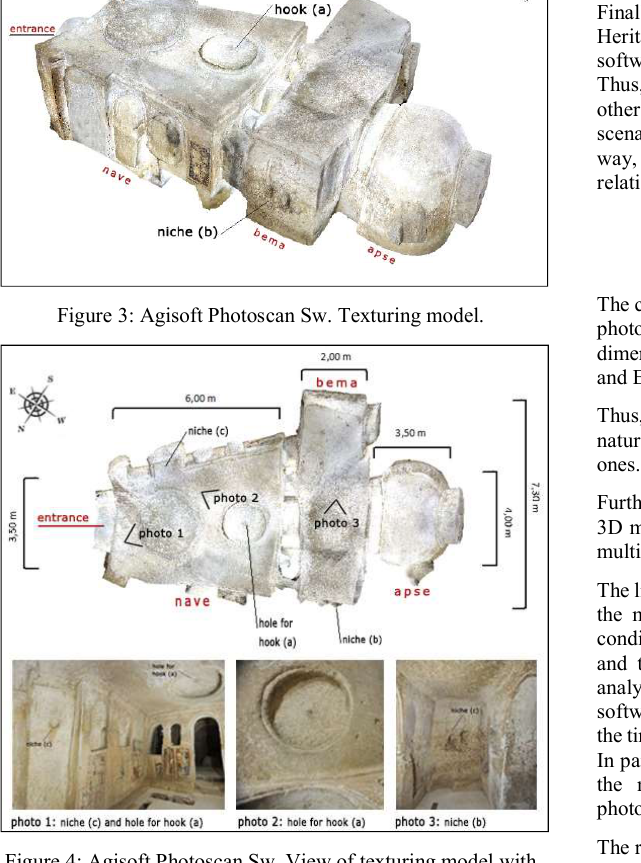
The next step was to import the model in 3D studio Max (Figure 5) in order to perform quantitative and qualitative studies of indoor lighting. The obtained model is so ready to the analysis of lighting scenarios because quality and lighting effect depend on the artefact geometry and the characteristics of its surfaces.